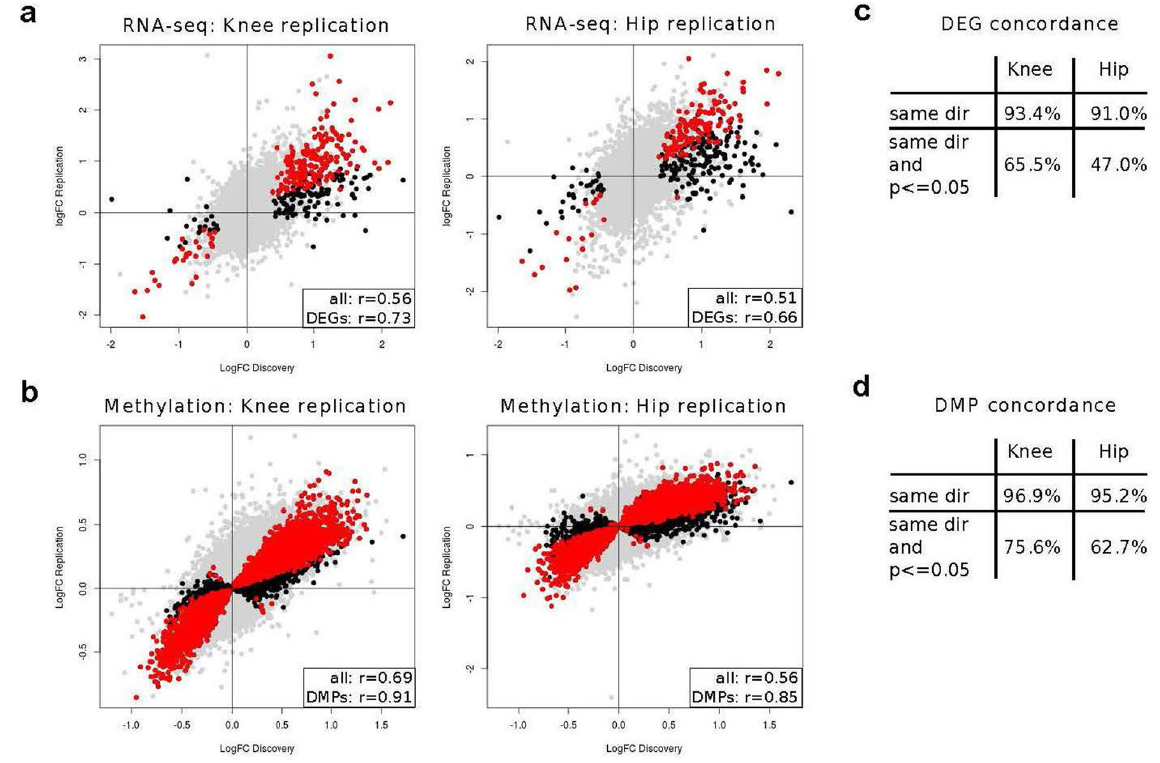
Figure 3. Replication of gene expression and methylation changes. ( a , b ) Replication of gene expression changes ( a ) and CpG methylation changes ( b ) in independent datasets of samples from patients with knee (left) and hip (right) OA. Differentially expressed genes ( a , DEGs) and differentially methylated probes ( b , DMPs) from the discovery data are marked in black; DEGs and DMPs that additionally show nominal significance in the replication data are marked in red. Inset: correlation between log-fold-changes in discovery and replication data. All: all 14,762 genes ( a ) or 416,437 probes ( b ) that passed QC in the knee discovery, knee replication, and hip replication data. DEGs: 332 of the 349 genes with FDR ≤ 5% in the knee discovery data that also pass QC in both replication datasets; DMPs: 9,723 of the 9,867 probes with FDR ≤ 5% in the knee discovery data that also pass QC in both replication datasets. All correlation values shown have p < 10 − 15 . ( c , d ) Directional concordance of changes between discovery and replication for the differentially expressed genes ( c , DEGs) and differentially methylated probes ( d , DMPs) from the discovery data. Same dir: proportion of DEGs or DMPs with same direction of change in the replication data. Same dir and p ≤ 0.05: among DEGs or DMPs with same direction of change in the replication data, proportion of those that reach nominal significance in the replication